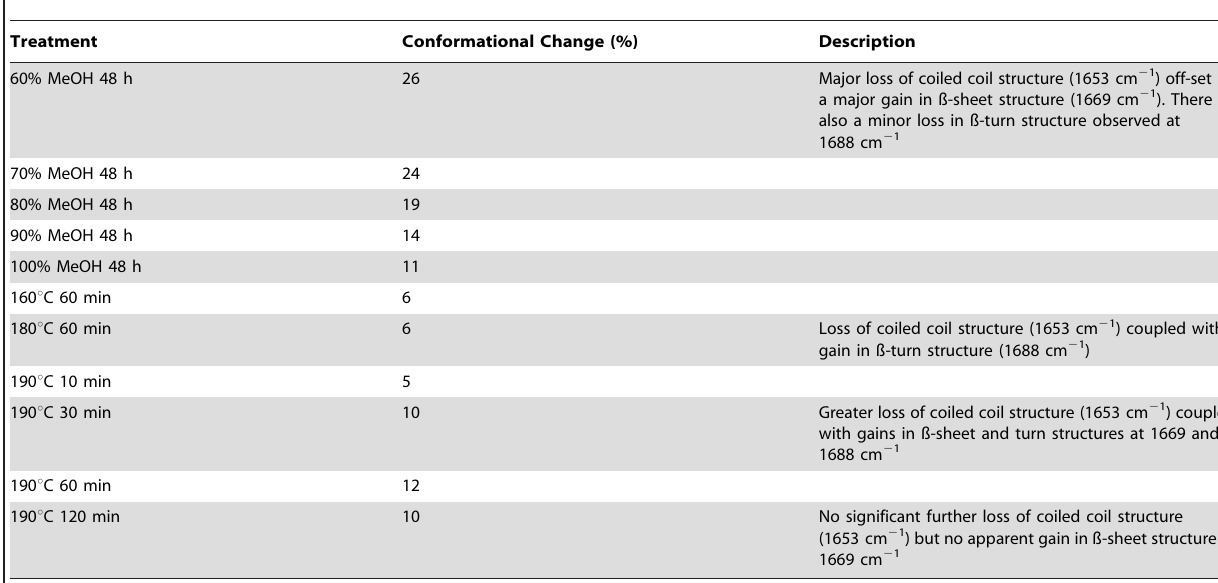
Table 2. Conformational change of recombinant honeybee silk materials as a function of stabilization